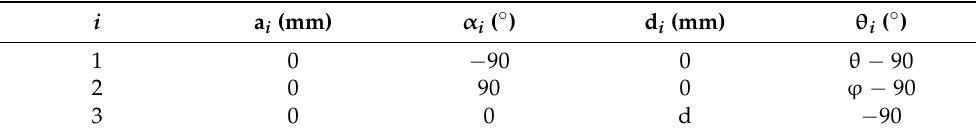
Figure 3. LT reference systems. Table 1. D–H initial